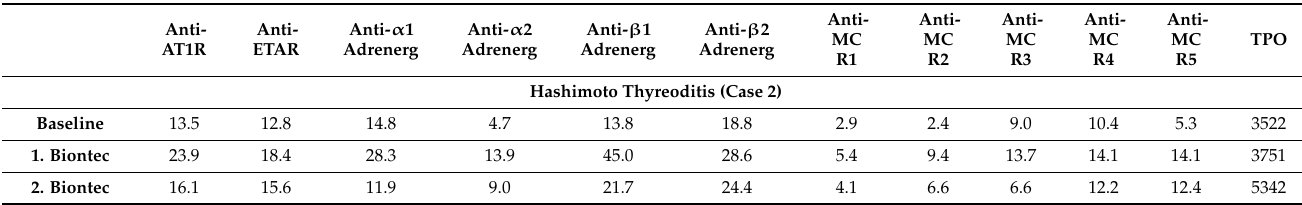
Anti-AT1R : anti-angiotensin 1 receptor autoantibody; anti-ETAR : anti-endothelin receptor autoantibody; anti-α1 adren-